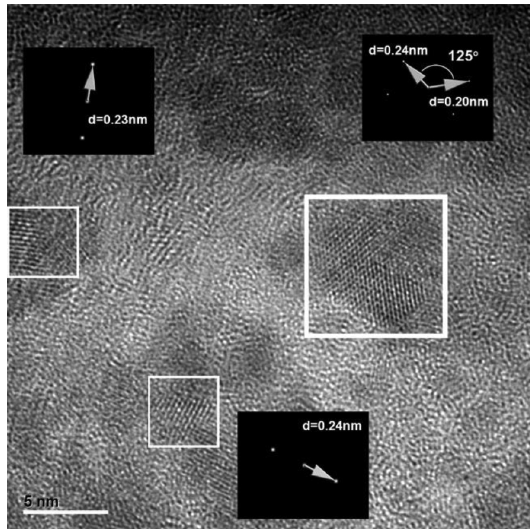
Figure 9. A typical HR-TEM view of the highly monodispersed and small nanoparticles obtained as our precursors dried. The insets show the determination of planar distances and angles by means of simulated electron diffraction experiments. In this case, micrographs correspond to a Sol-2575